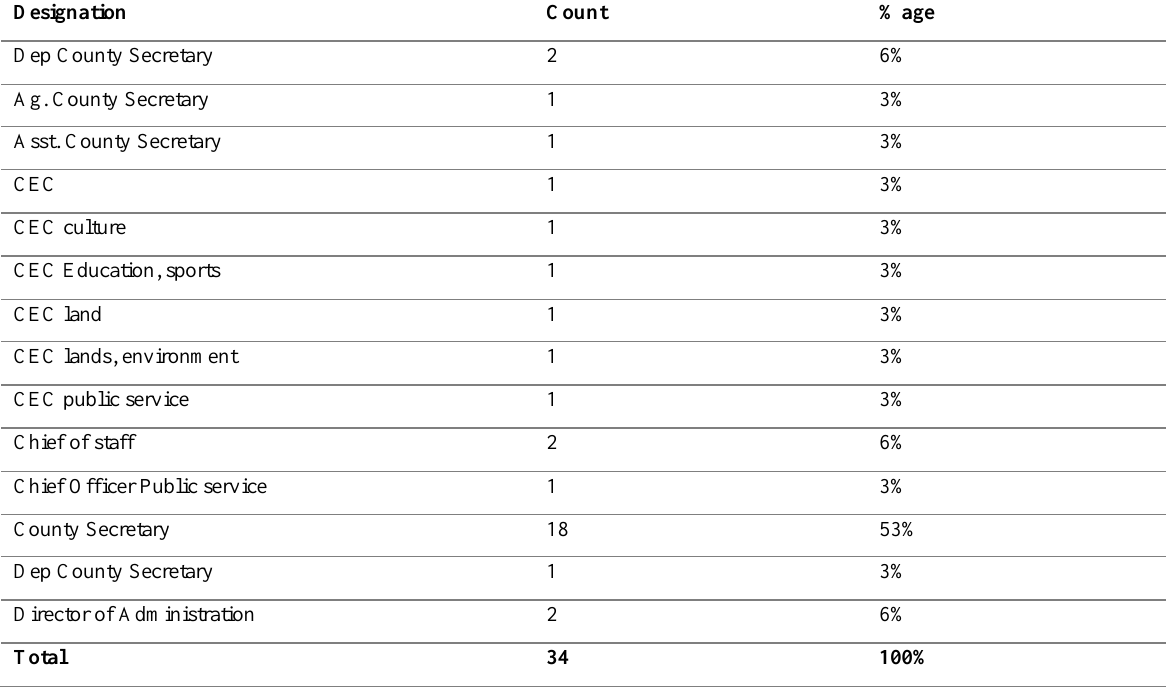
Table 6: County executives by designation